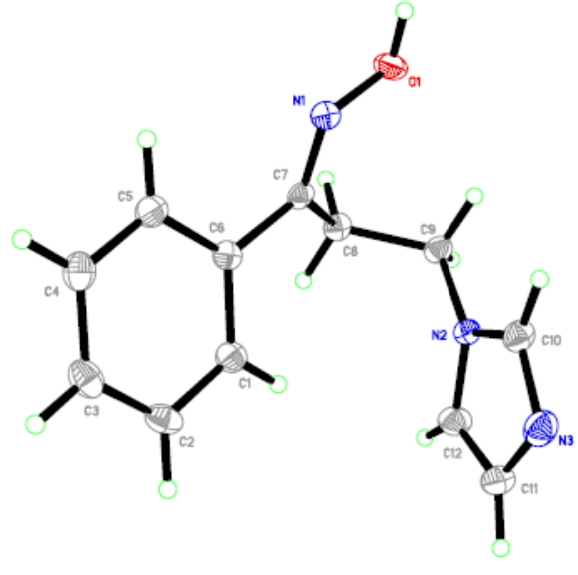
Figure 2. ORTEP diagram of the title compound 4a drawn at 50% ellipsoids for non-hydrogen atoms.